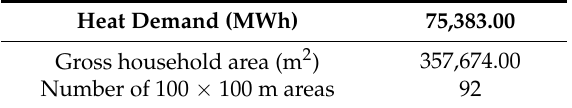
Table 2. Main results of the district heating implementation feasibility analysis.